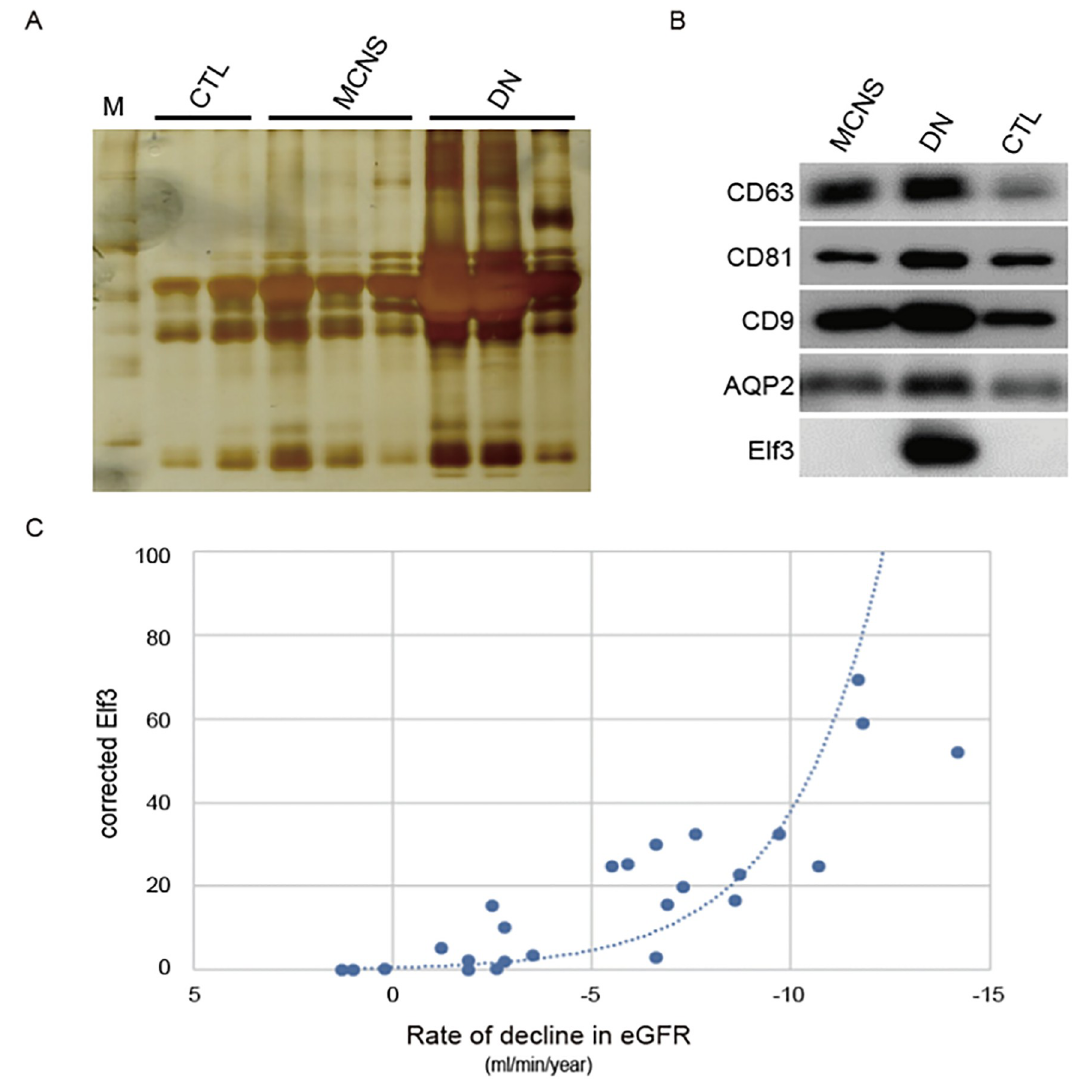
Fig 5. Expression levels of Elf3 and changes in eGFR after measurement of Elf3. (A) Urinary exosomes obtained from patients with MCNS and DN, and healthy subjects (CTL) were assayed by SDS/PAGE and visualized by silver staining. The molecular weight marker was indicated on the left. (B) Western blotting of urinary exosomes in pooled urine samples collected from patients with DN (n = 25) and MCNS (n = 25), and healthy subjects (CTL) (n = 5) using antibodies specific for CD63, CD81, and CD9. (C) Rate of change in eGFR after the measurement of urinary exosomal Elf3 protein levels in the patients with DN. R 2 = 0.7259. patients with DN, patients with MCNS, and healthy subjects were analyzed by silver staining (Fig 5A). The loading volume for immunoblotting was normalized to the urinary creatinine content. The amount of exosomes obtained from patients with DN was higher than that obtained from patients with MCNS or healthy subjects. Next, we examined whether aqua- porin-2 (AQP2) is expressed in the exosomes from the three groups, as excretion of AQP2 in urinary exosomes has been reported in healthy subjects who had no evidence of recent kidney or urinary tract disease [23]. While AQP2, as well as tetraspanins, could be detected in all three groups, by western blotting, excretion of Elf3 in urinary exosomes was restricted to the urine obtained from patients with DN (Fig 5B). This is compatible with the fact that glomerular